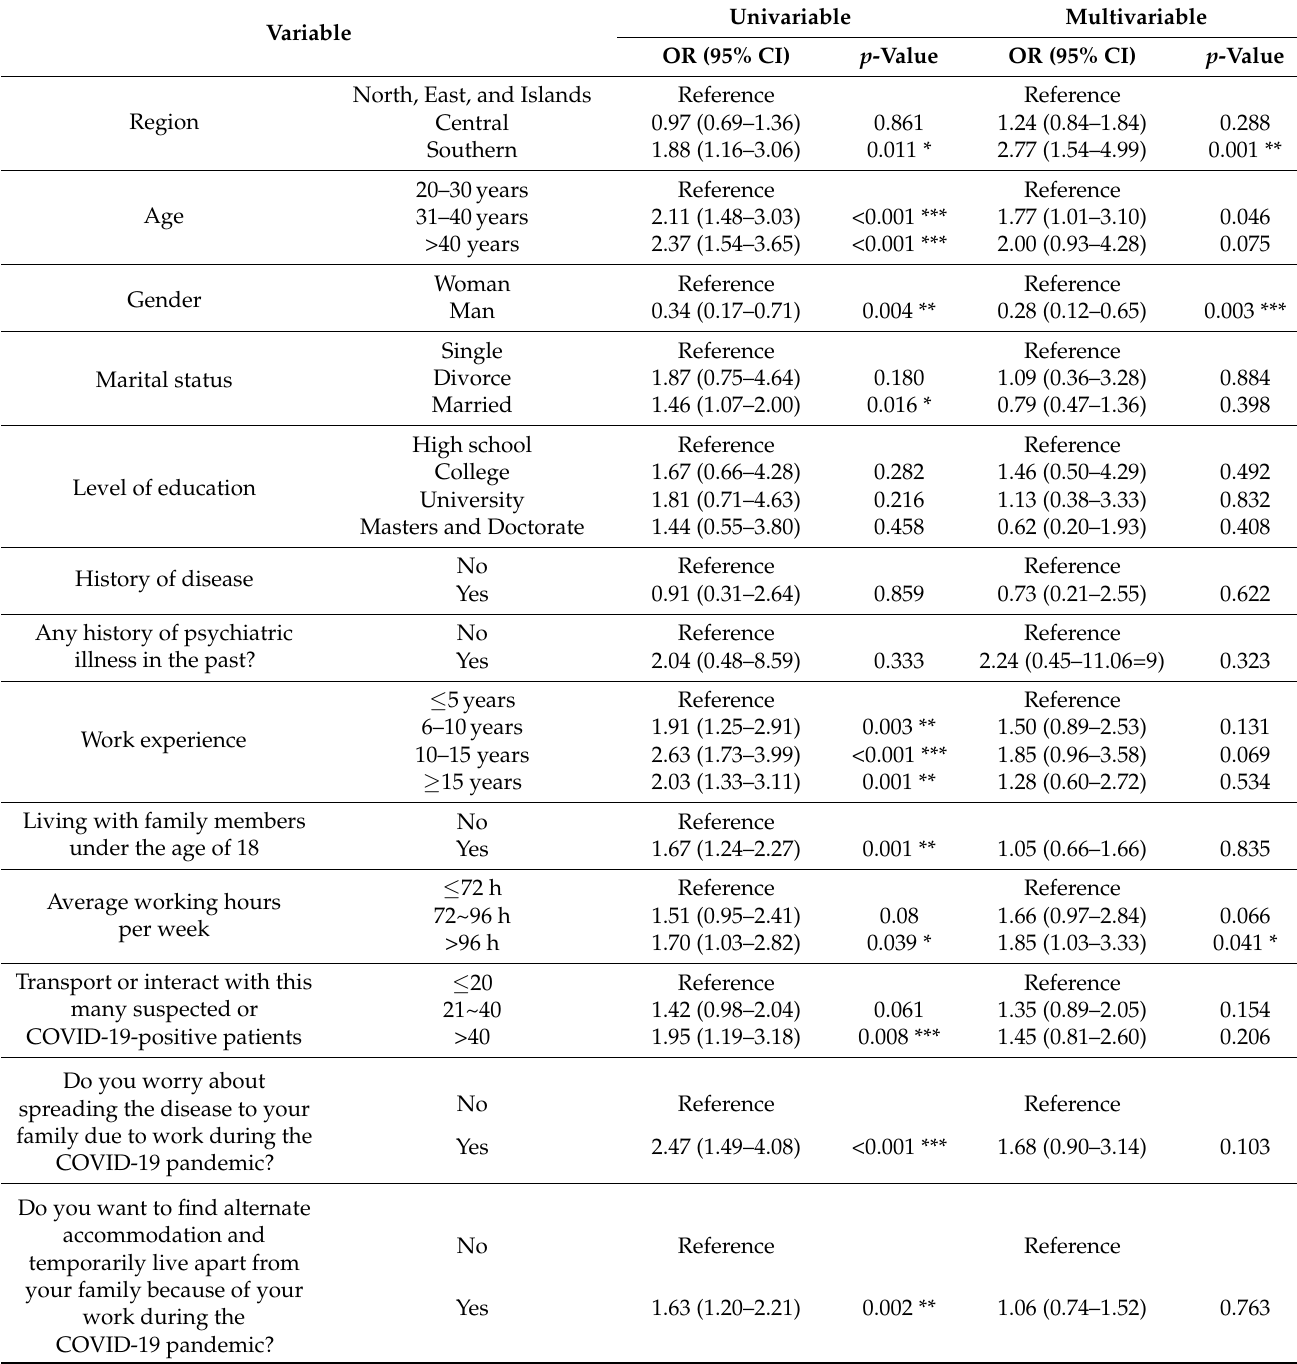
Table 4. Anxiety odds